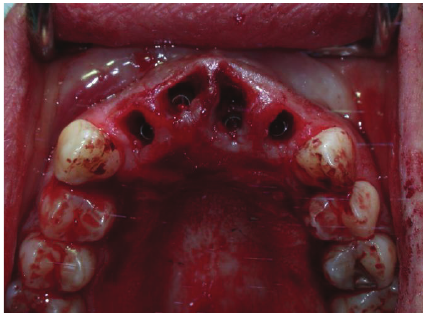
Figure 7: Postsurgical X-ray showing implants after surgery with provisional abutments inserted.